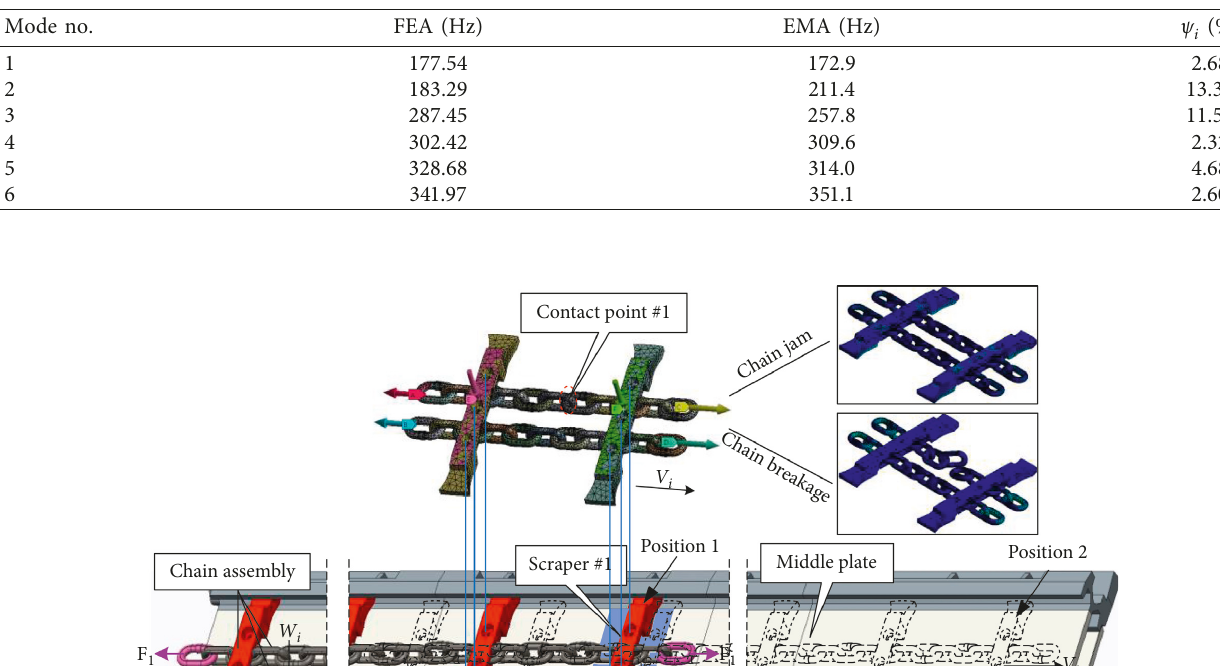
Table 1: Frequency response of vibration signals.